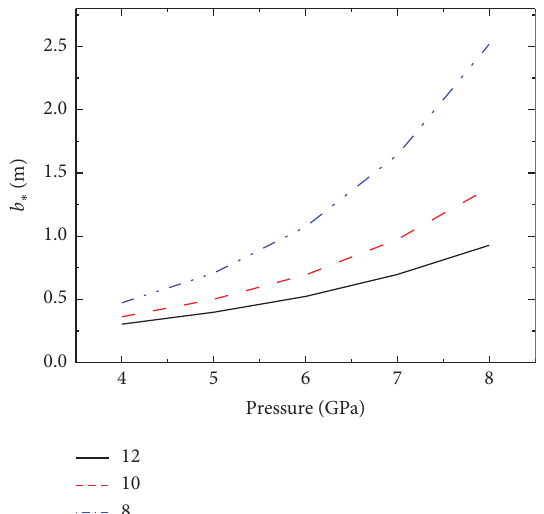
Figure 6: Change curve of the crushed zone under different P ∗ c values of the spherical charge.